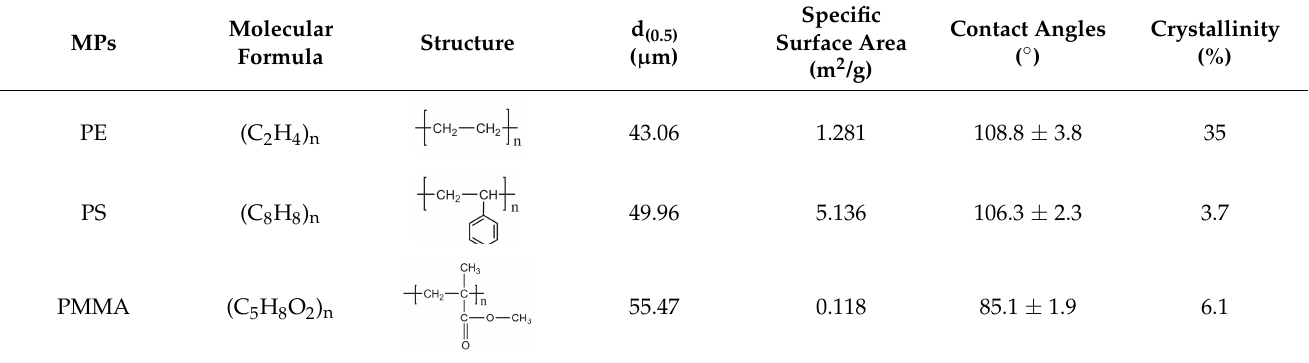
Table 1. Structure and basic physical and chemical characters of PE, PS, and PMMA.